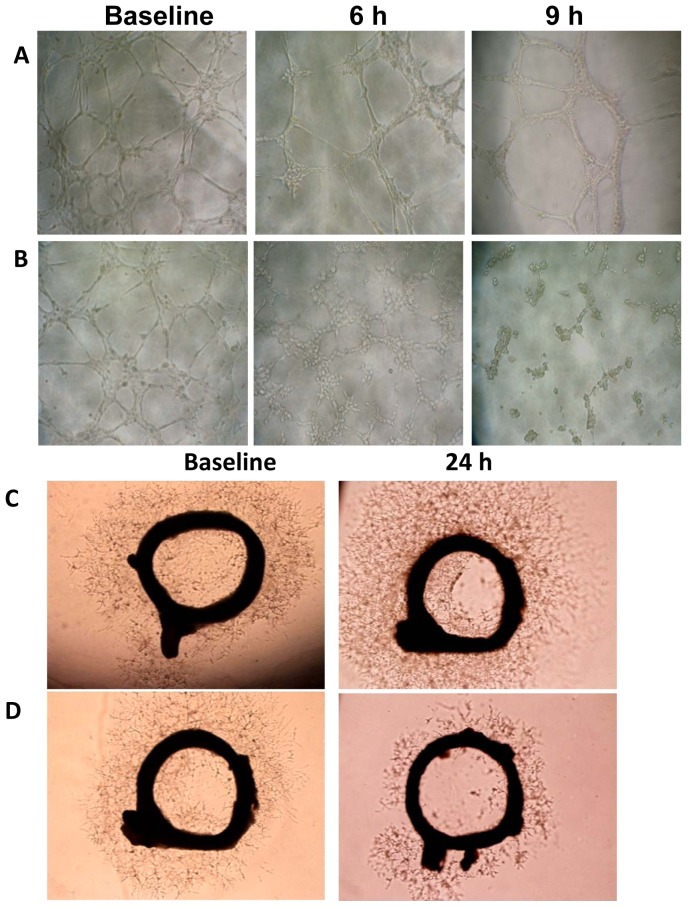
BPR0L075 disrupts pre-established HUVEC capillary-like networks.HUVEC cells were seeded in a 96-well tissue culture plate coated with Matrigel for 12 hours before exposure to ethanol vehicle (A) or 10 nM of BPR0L075 (B) and cells were photographed at different time points. BPR0L075 decreased vessel sprouting ex vivo. Incubation of freshly isolated rat aorta (1 mm thick rings) in 1∶1 Matrigel and RPMI medium containing 20 ng/mL VEGF generated vessel sprouts after 48 hour (baseline). Medium was replaced with fresh medium containing ethanol vehicle (C) or 10 nM of BPR0L075 (D) for an additional 24 hour. Representative images show massive vessel spouting in control rings, but reduced vessel sprouting in BPR0L075 treated rings. All experiments were repeated three times.